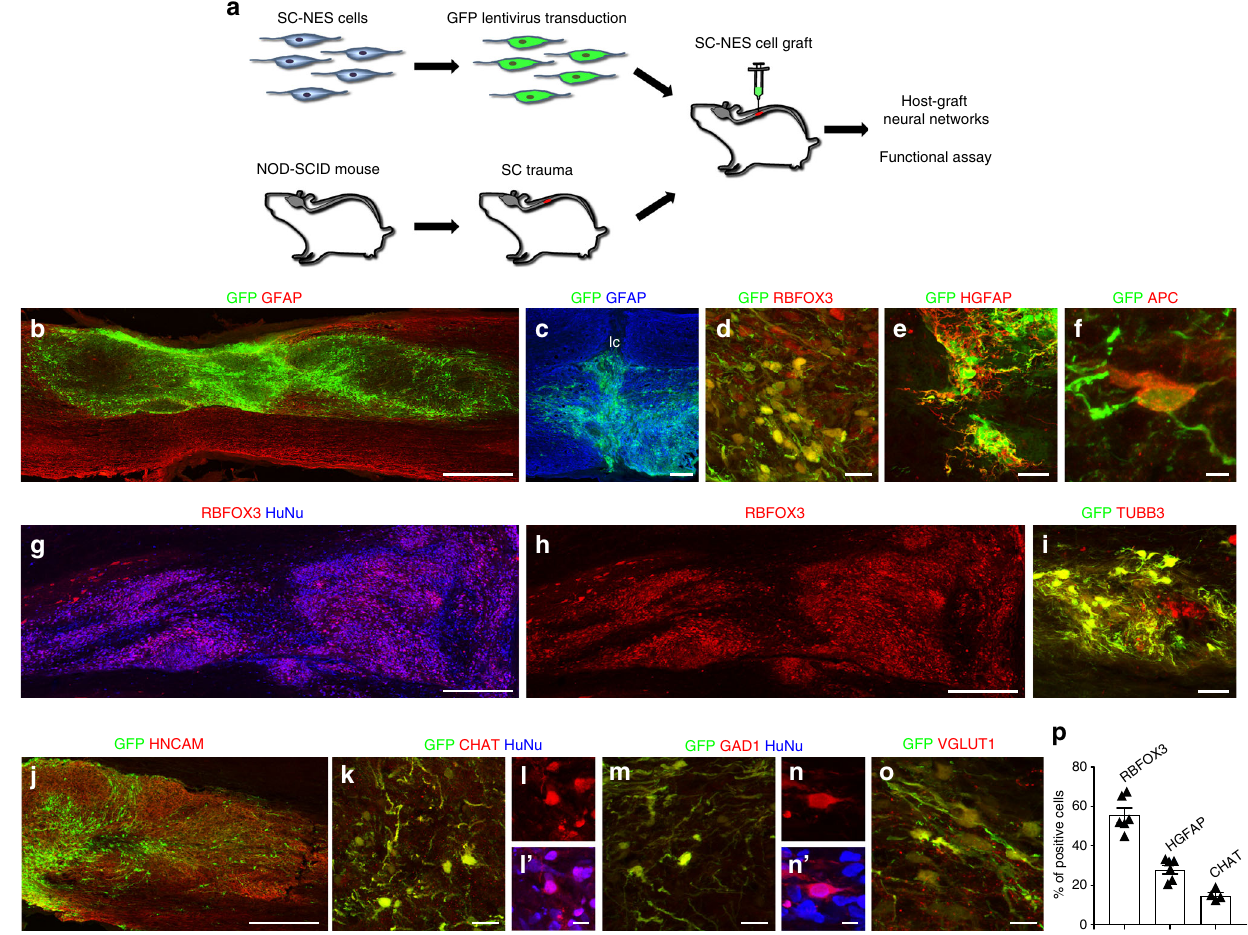
Fig. 2 Human SC-NES cell graft survival and in vivo differentiation in a model of SCI. a Schematics of the experimental procedure. SC-NES cells were transduced with a GFP lentiviral construct before engraftment. Recipient immunode fi cient (NOD/SCID) mice underwent dorsal SC hemisection and received SC-NES cell injection onto the lesion site 10 days after. b GFP-labeled SC-NES cells were implanted into the site of the injury. Horizontal section immunolabelled for GFP and GFAP indicates that cell implants survive and distribute into the lesion cavity. Rostral is to left, caudal is to right. c High magni fi cation of the lesion core (lc) showing the correct placement of the cells in the injured area. d The majority of the cells within the graft differentiates toward the neuronal fate giving rise to RBFOX3-positive neurons. e , f SC-NES cells also generate astrocytes positive for human GFAP (HGFAP) and oligodendrocytes positive for APC. g , h Low magni fi cation image of grafted cells immunostained with RBFOX3 and human nuclei (HuNu) antibodies, con fi rming the human origin of differentiated cells. i , j Grafted GPF-labeled cells are also positive for the neuronal markers TUBB3 and HNCAM. k – l ′ A fraction of GFP-labeled SC-NES cells colocalize with the motor neuronal marker choline acetyltransferase (CHAT) and co-staining with HuNu antibody con fi rms the human origin of the cells. m – n ′ Immunostaining for GFP, HuNu and the inhibitory neuronal marker glutamate decarboxylase 1 (GAD1) showing colocalization of GAD1 staining with GFP and HuNu. o Double labeling for GFP and vesicular glutamate transporter 1 (VGLUT1) showing a graft- derived human neurite co-expressing VGLUT1. p Quanti fi cation of RBFOX3-positive neurons (55.6 ± 3.6%) and HGFAP-positive astrocytes (27.9 ± 2.2%) representing the two largest cellular subtypes in the graft. Among neurons, CHAT-positive motor neurons were the most abundant subtype accounting for up to 14.7% of grafted cells. Scale bars: b 500 µ m; c 200 µ m; d 20 µ m; e 40 µ m; f 4 µ m; g , h 500 µ m; i 40 µ m; j 250 µ m; k 20 µ m; l , l ′ 10 µ m; m , 20 µ m; n , n